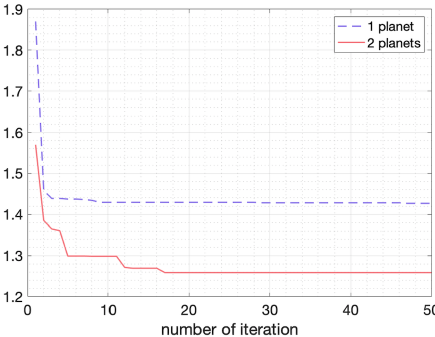
( t ) ( 0 ) = 50 as starting value (the ML . We decide (cid:98) σ ML ( 1 ) ML . The dashed